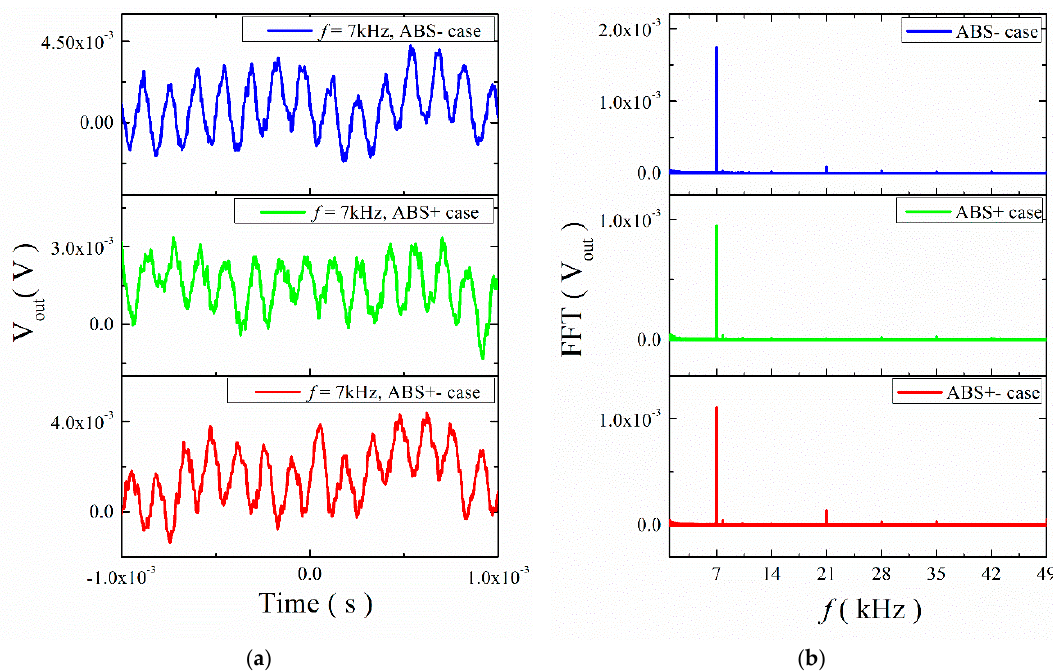
Figure 9. ( a ) Waveforms of ME voltage in the time domain for the ME structure with ABS trestle at 7 kHz; ( b ) the FFT spectral pattern for ME voltage.